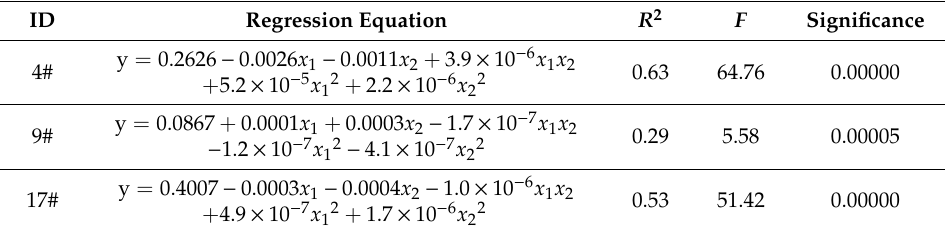
Table 3. Regression equations of points 4, 9, and